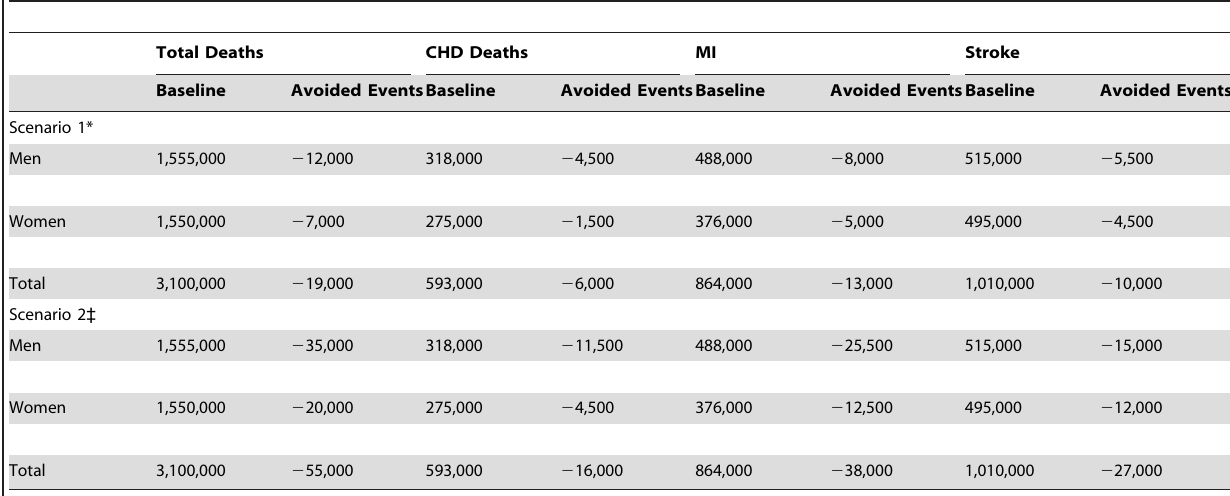
Table 3. Absolute number of baseline and avoided events in Scenario 1 and 2 from